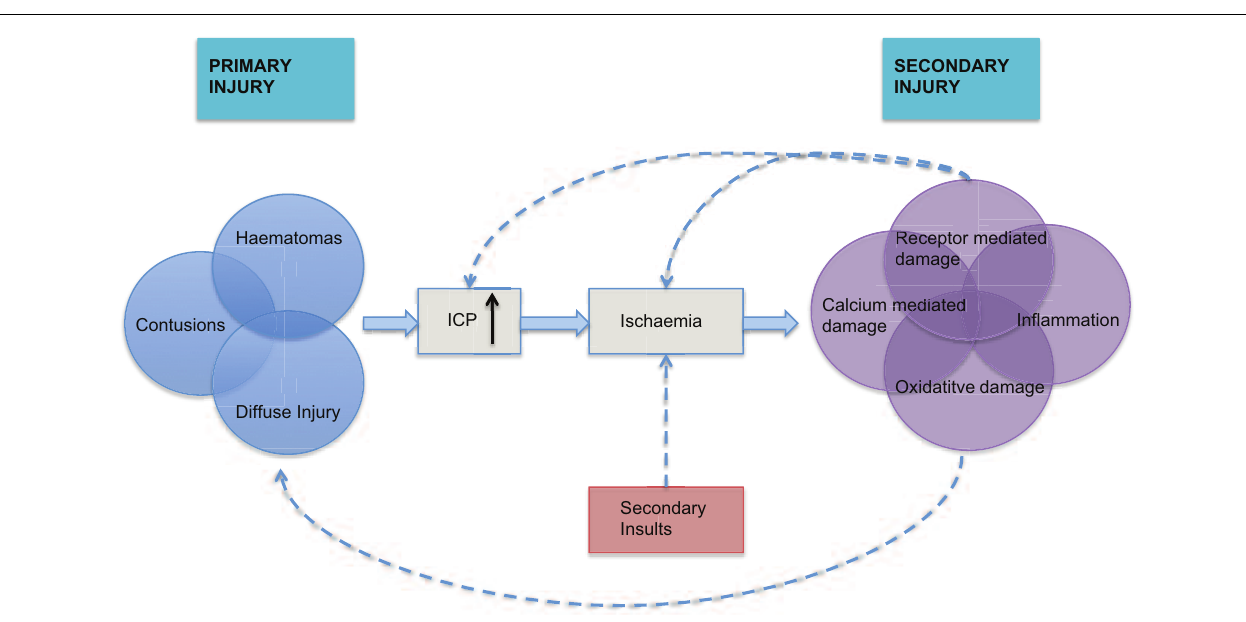
FIGURE 1 |The inter-relationship between primary and secondary injury inTBI is shown . Secondary physiological insults can potentiate ischemia and lead to exacerbation of secondary injury. ICP = intracranial pressure, adapted from Mass et al. (2).